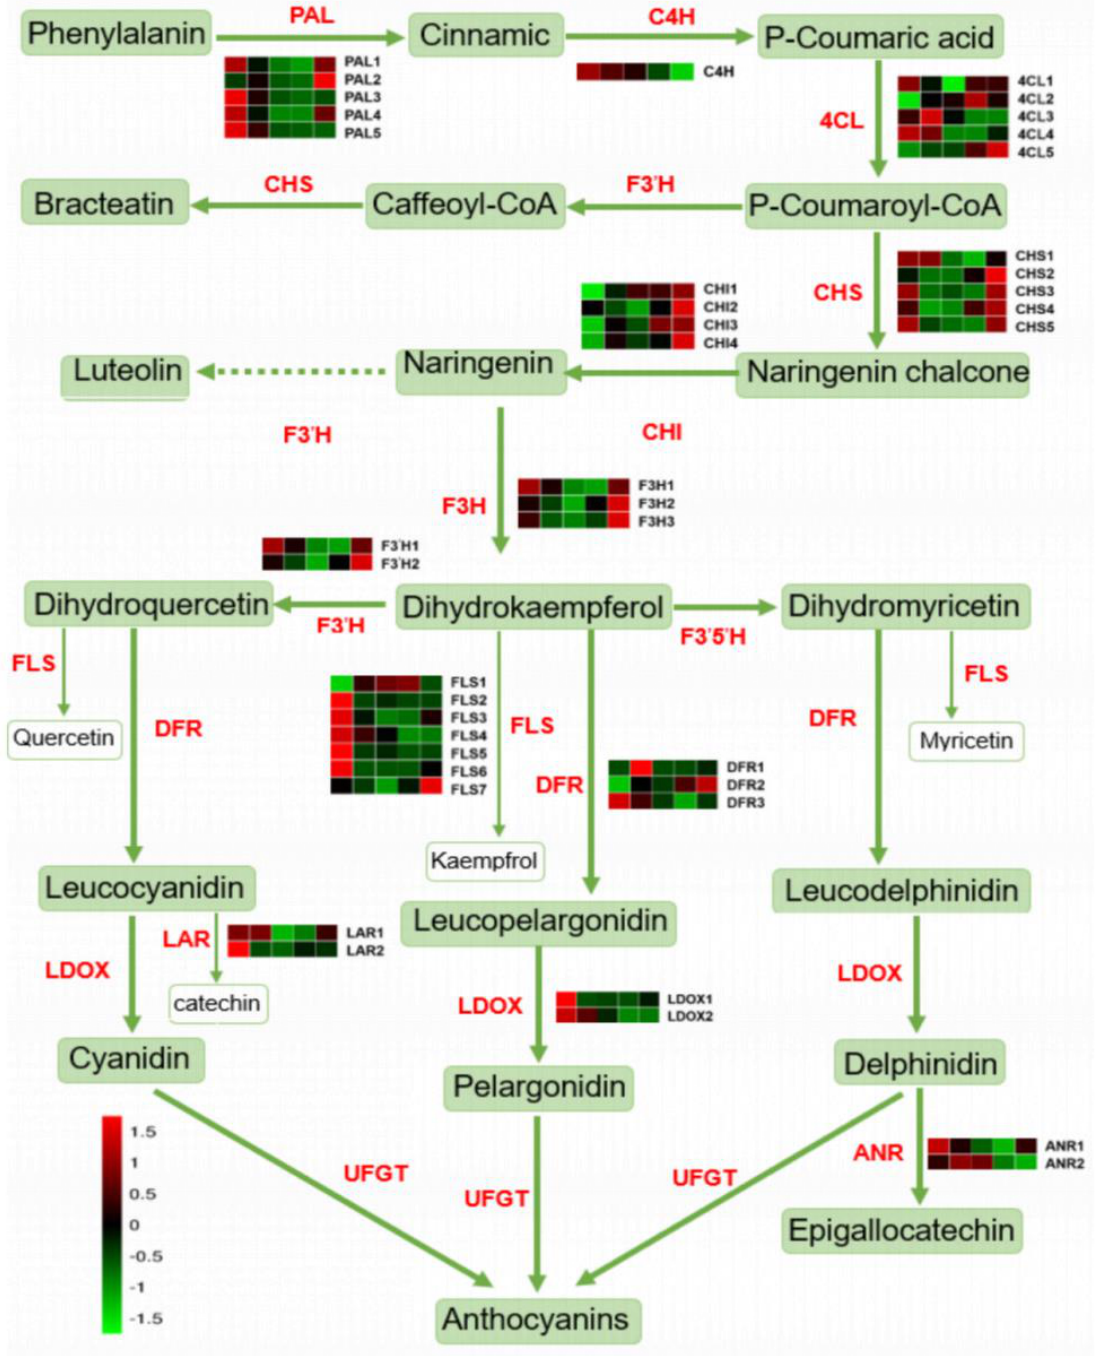
Figure 2. Comprehensive metabolic map of flavonoids. The gene name is on the right side of the heat map, and the FPKM value of each gene is expressed in different colors, with five cells from left to right representing samples of 20 d–176 d, respectively; the color scale from dark blue to bright red represents relative expression levels −1.5– 1.5. The name of the enzyme gene is on the side, and the FPKM of each gene is expressed in different colors and the five cells from left to right represent samples of 20 d – 176 d.